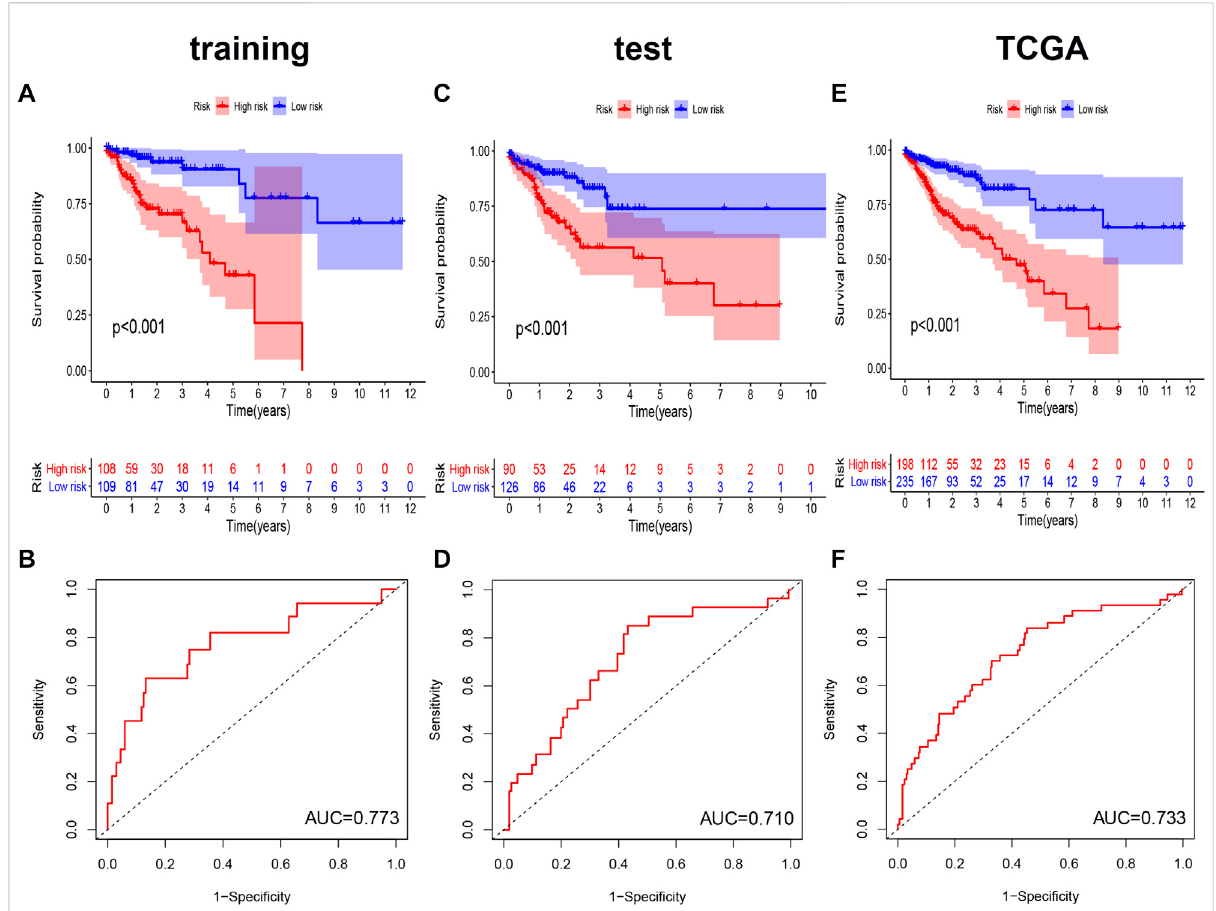
FIGURE 5 Kaplan-MeiercurvesandROCcurvesoftheprognosticASmodels. (A,C,E) Kaplan-Meierplotsofthegenomicinstability-relatedASsignaturein the training set (A) , the test set (C) , and the entire TCGA set (E) . (B,D,F) The ROC curves for overall survival of the genomic instability-related AS signature in three datasets, respectively. ROC, Receiver operating